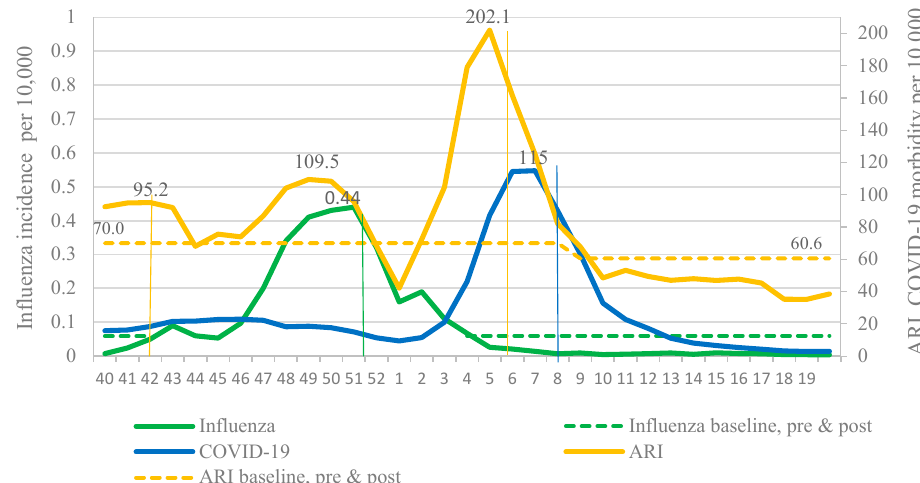
Figure 4. Comparison of the dynamics of the incidence of influenza, ARI and COVID-19 in the cities of the Russia under observation, 2021–2022 season.